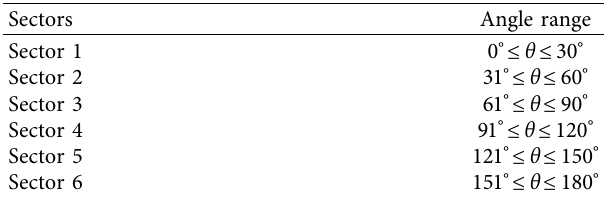
Table 1: Division of forward workspace referring to the angles from the position of the mobile